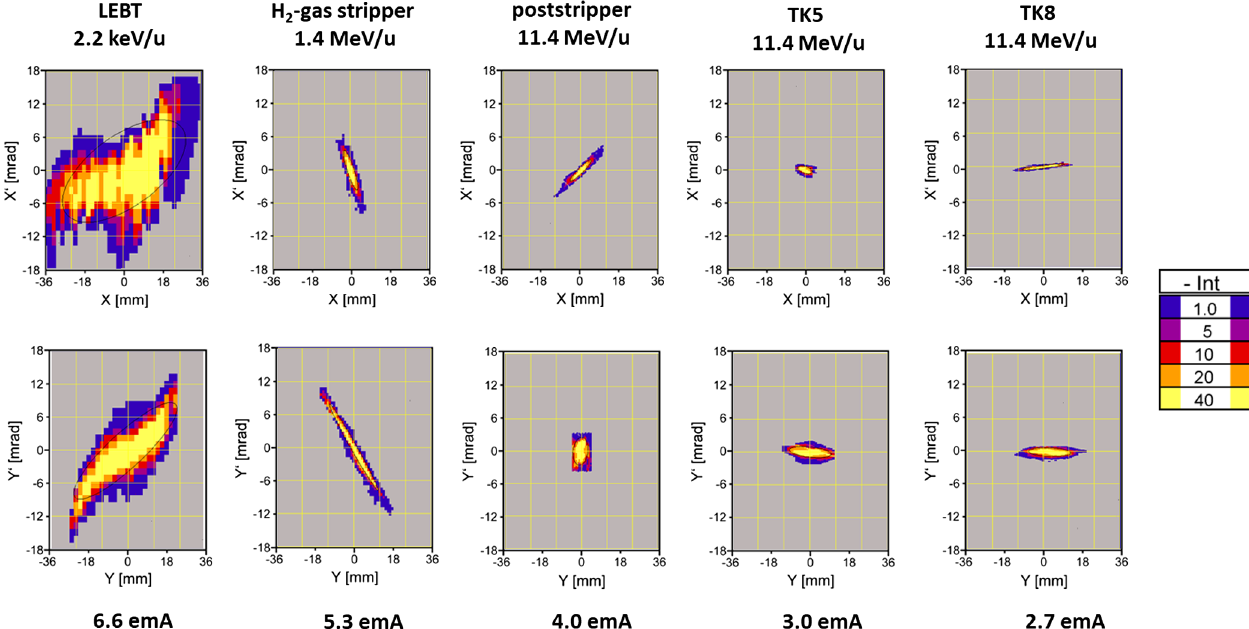
FIG. 6. High-intensity 209 Bi-beam emittance and current measurement along UNILAC and transfer line to